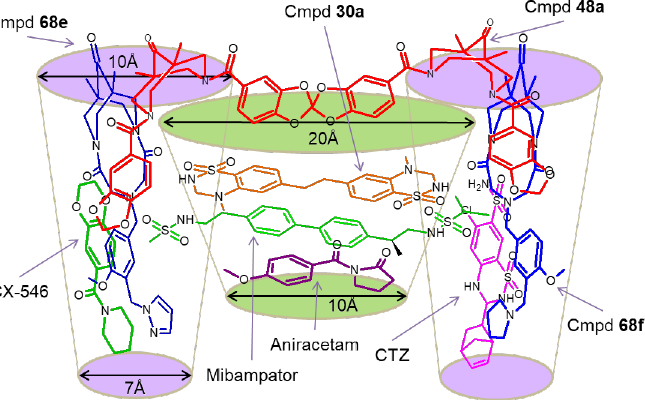
Figure 5. The overall architecture of the AMPA receptor positive allosteric modulator binding site and the location of some key modulators according to the X-ray diffraction analysis, molecular docking, and molecular dynamics. The central pocket is marked in green; the symmetrical side pockets are marked in purple.